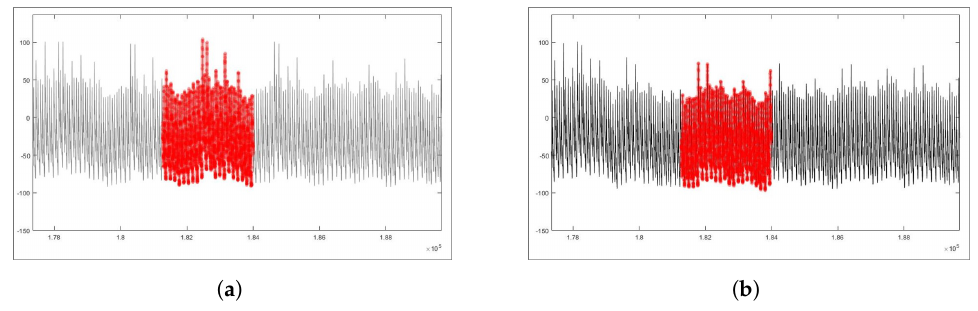
Figure 1. ( a ) power consumption trace when subtraction result is negative; ( b ) power consumption trace when subtraction result is